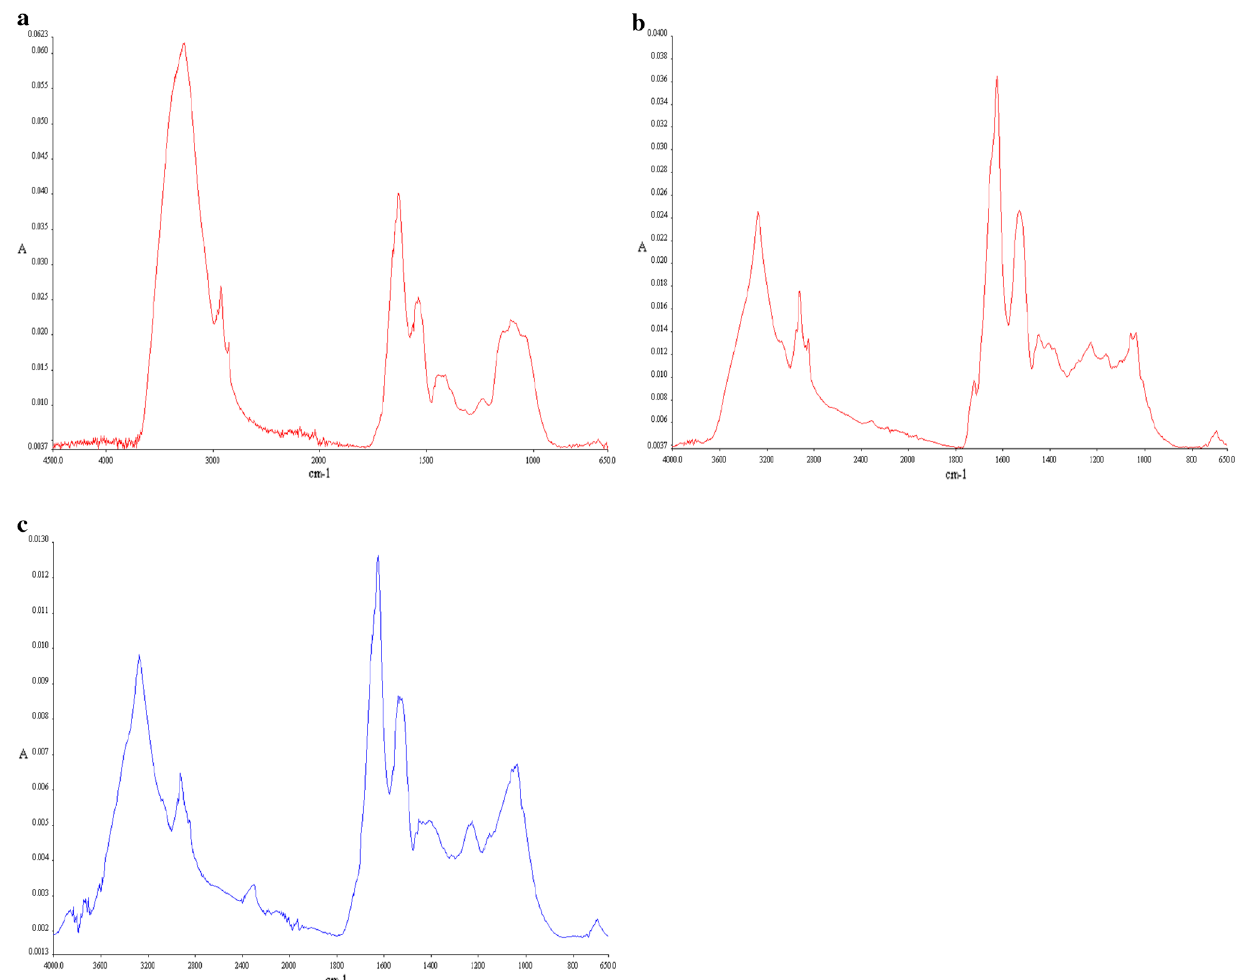
Fig. 13 ATR/FTIR spectra of Foulant deposits on membranes a Koch, b Hydranautics, c